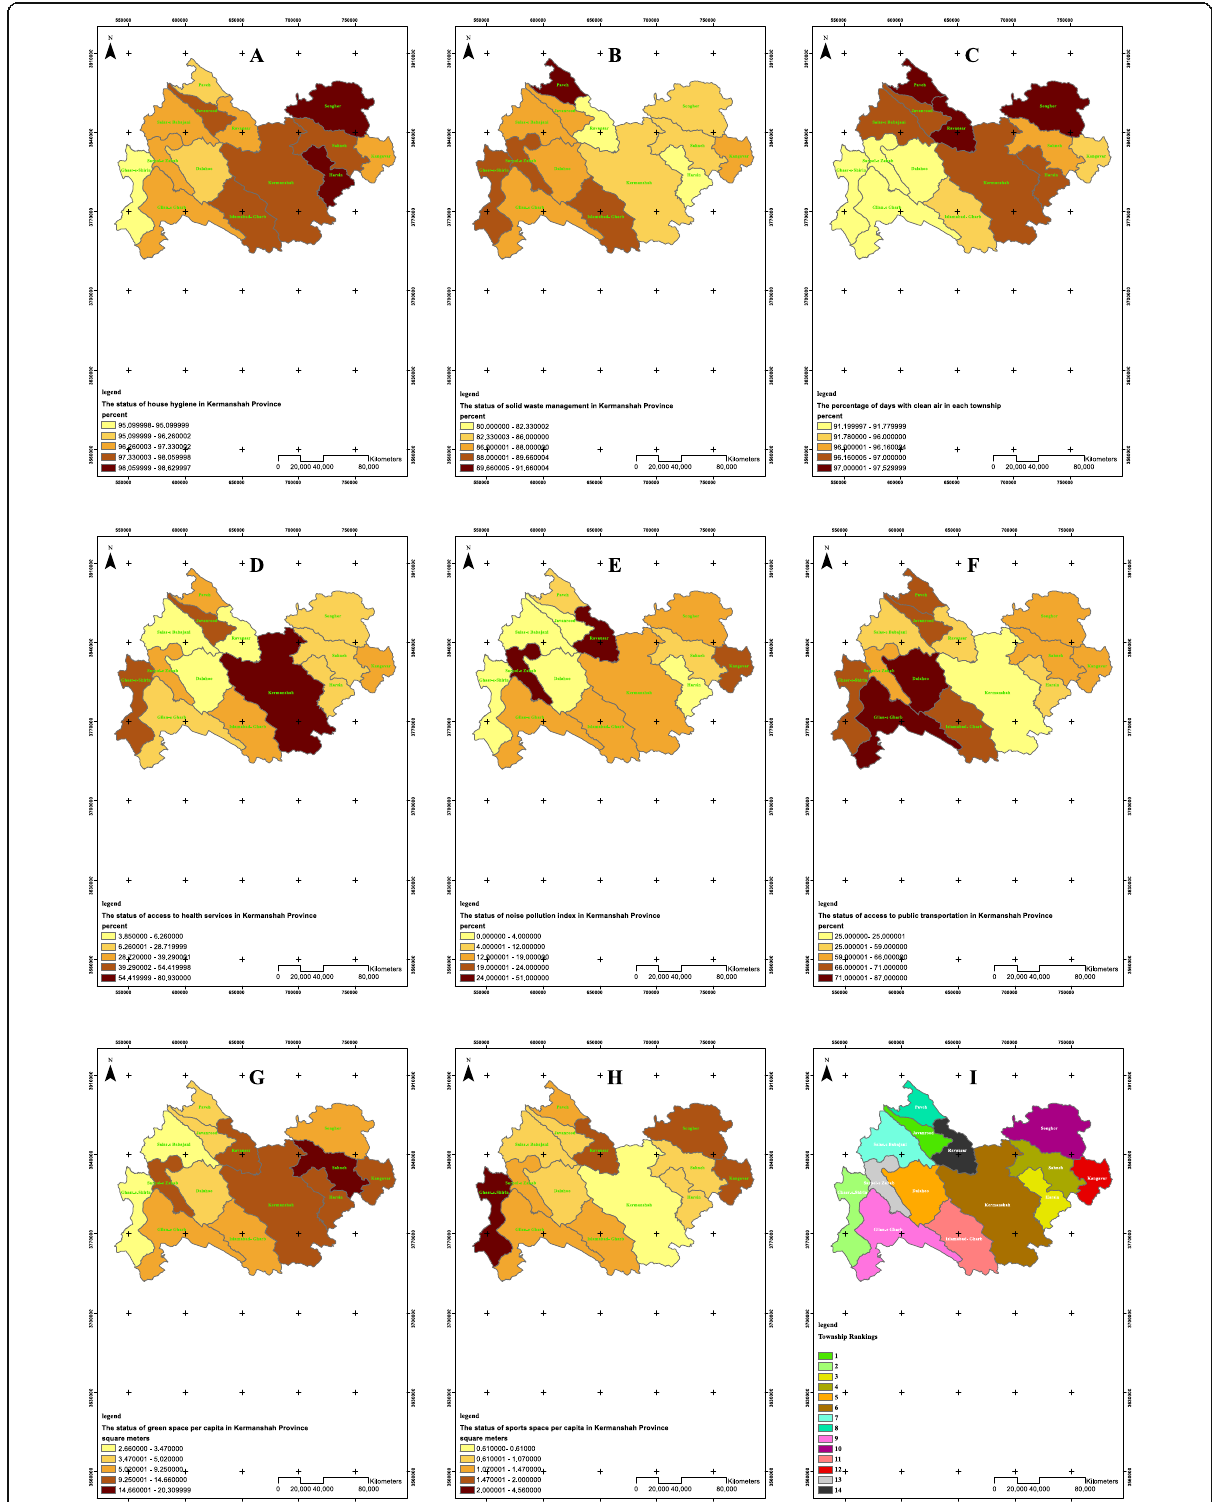
Fig. 1 The map of the status of health equity in physical and infrastructure indexes and counties ranking in Kermanshah province in 2016 using